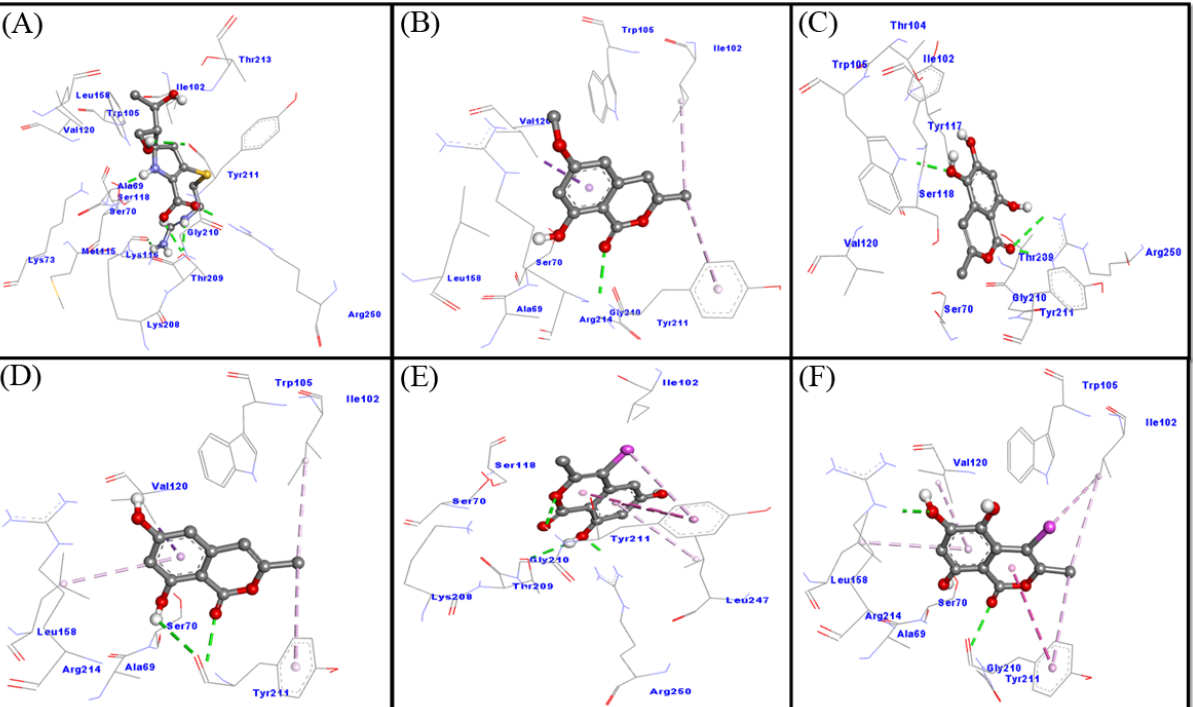
Figure 5. Binding mode of the ligands: imipenem ( A ); Compound 1 ( B ); compound 2 ( C ); compound 3 ( D ); and compound 4 ( E ) and compound 5 ( F ) inside the active site of OXA-48.